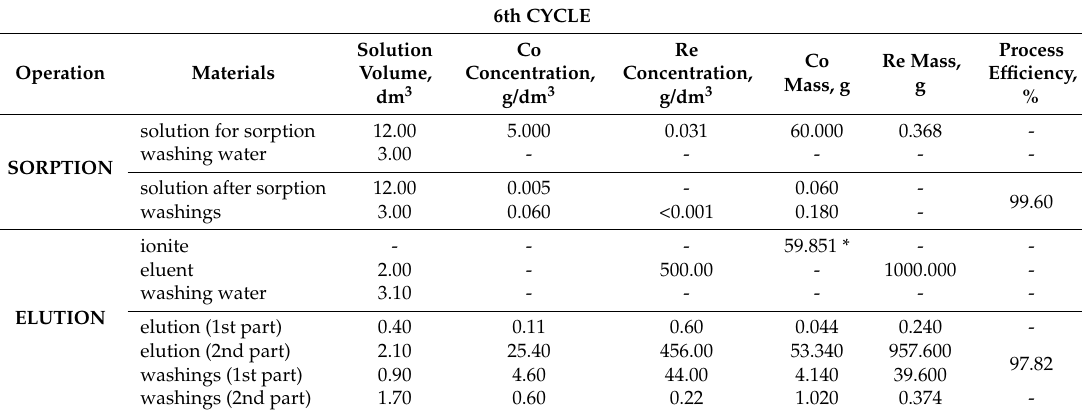
Table 13. Balance for cobalt(II) sorption and elution—6th cycle. 6th